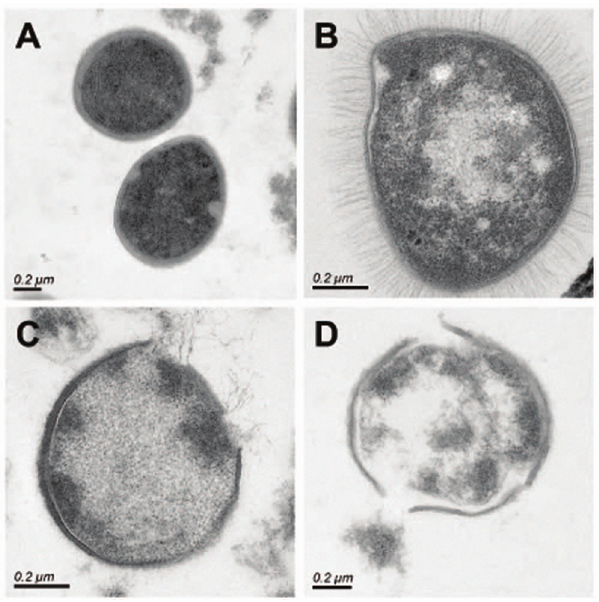
Figure 6. Thin sectioned electron micrographs of S. aurues analyzed by transmission electron microscopy. The cells were fixed 10 minutes after HT61 treatment. A. normal S. aureus cells. B. HT61 at 10 m g/ml. C. HT61 at 20 m g/ml. D. HT61 at 40 m g/ml. The scale bar is 0.2 m m.